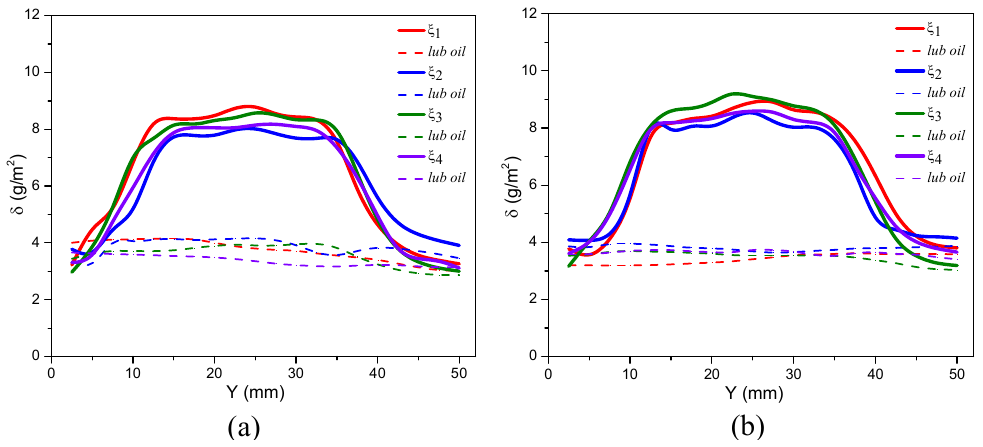
Figure 7. Longitudinal section profiles of adhered fuel film for ( a ) B15 and ( b ) B25 blends under FWW conditions.